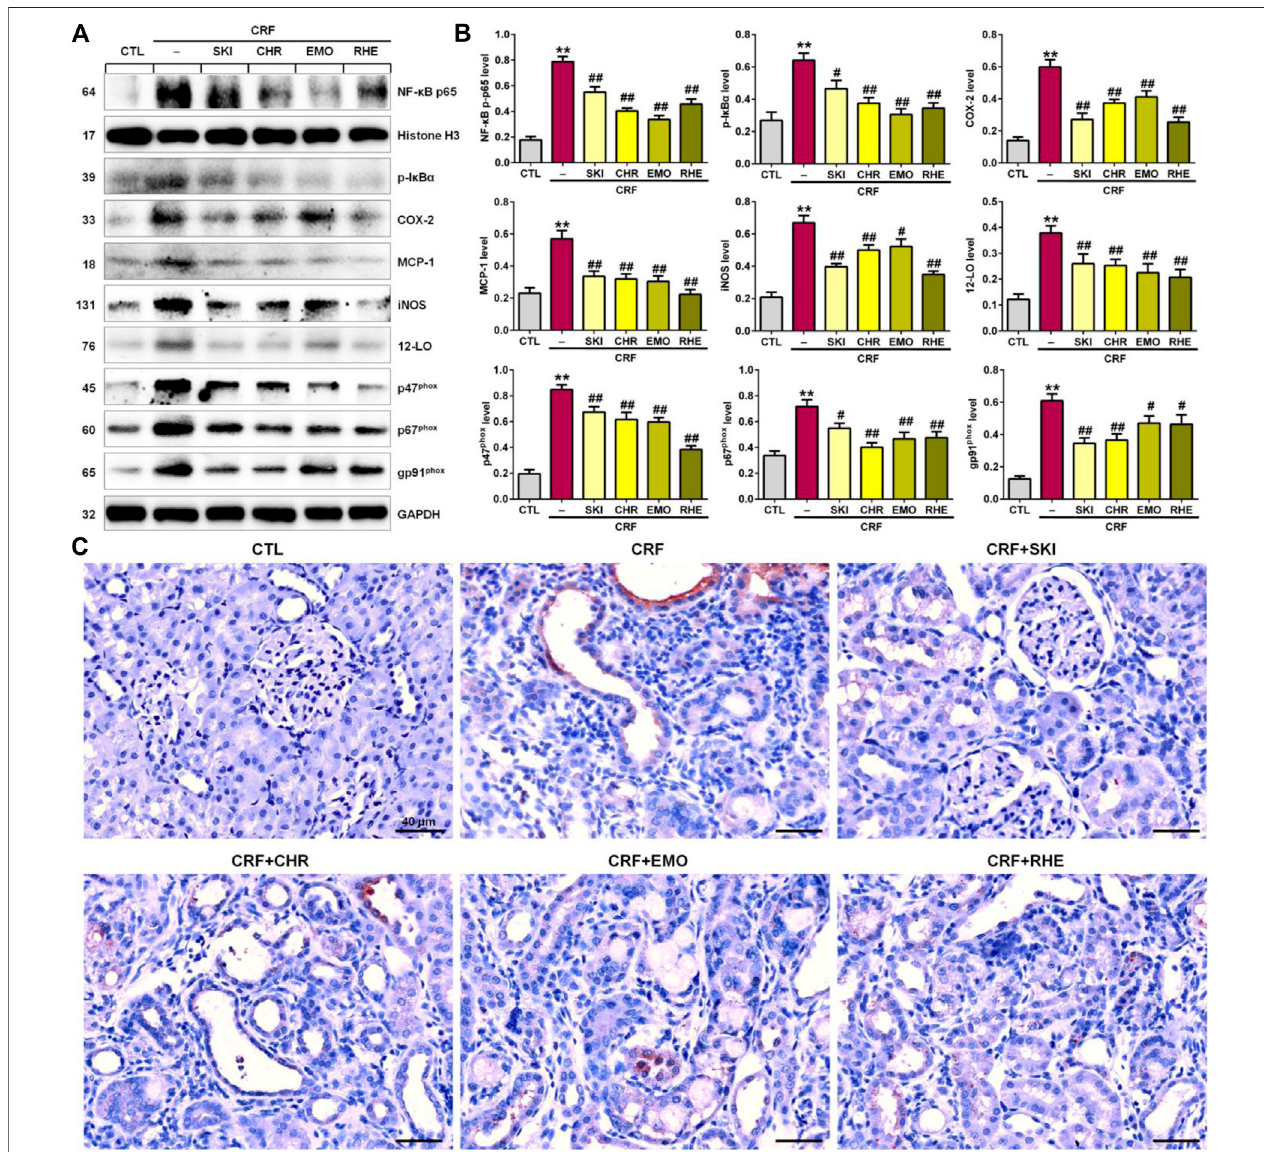
FIGURE 4 | SKI and three anthraquinones including chrysophanol, emodin, and rhein inhibited the pro-in fl ammatory I κ B/NF- κ B signaling pathway in the adenine- induced CRF rats. (A) Protein expressions of nuclear translocation of p65 and its downstream gene products including COX-2, MCP-1, iNOS, 12-LO, and NAD(P)H oxidase subunits (p47 phox , p67 phox , and gp91 phox ) of the kidney tissues in the different groups. (B) Quantitative analysis of pro-in fl ammatory and pro-oxidative protein expressions of the kidney tissues in the different groups. ** p < 0.01 compared with the CTL group; # p < 0.05, ## p < 0.01 compared with the CRF group. (C) Immunohistochemical analysis with anti – COX-2 of the kidney tissues in the different groups. Scale bar, 40 μ m.